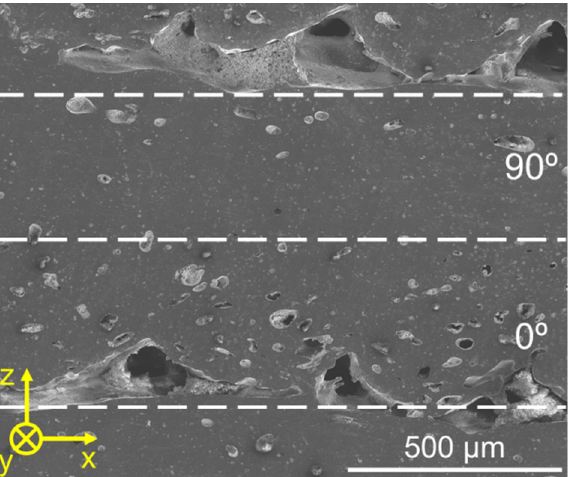
Figure 18. Cross section of C6 before testing. Dashed lines indicate the layer orientation boundaries; 0° layers were printed parallel to the y axis, whereas 90° ones were printed perpendicular to it.